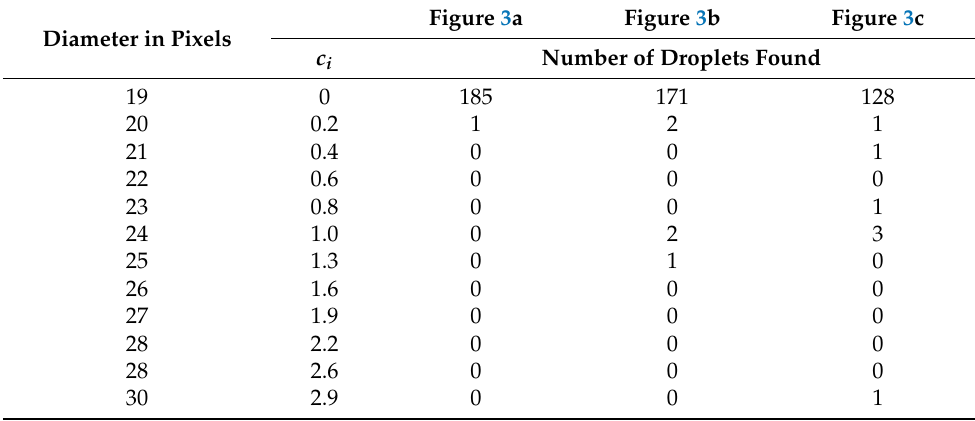
Table A1. Exemplary table for the analysis of coalescence events from the micrographs from Figure